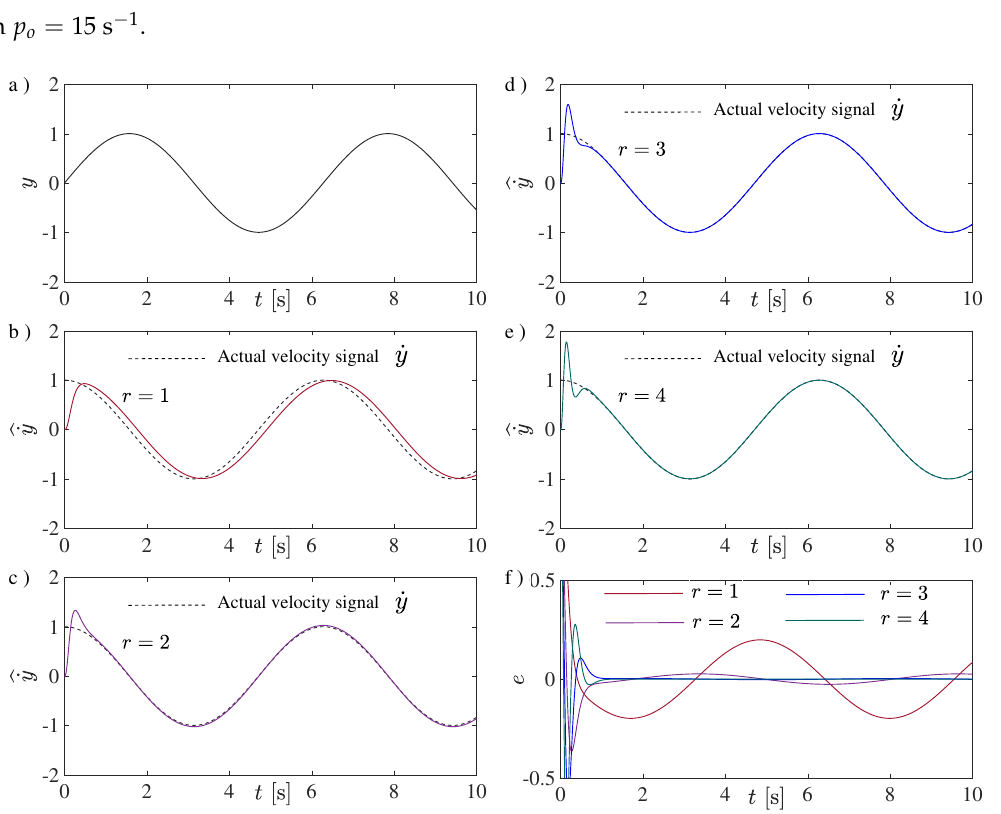
Figure 2. ( a ) Measured output signal. Polynomial differentiation using Taylor series expansions: ( b ) first order, ( c ) second order, ( d ) third order, ( e ) four order. ( f ) Estimation error e = ˙ y − (cid:98) ˙ y